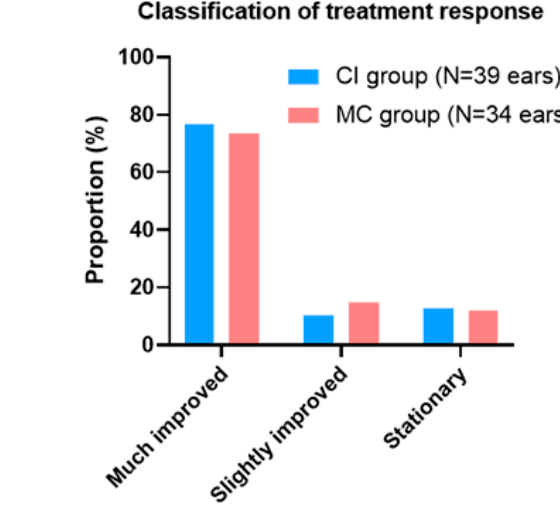
Figure 5. Comparison of erythema score during follow-up periods between the two groups. ( A ) Within CI group. ( B ) Within MC group. (*: statistical significance, ns: no statistifcal significance) 4. Discussion The current study compared the therapeutic efficacy of PEAC treatments between the CI and MC groups. Both groups showed favorable treatment outcomes following ter- mination of the self-application treatment according to the cross-sectional and longitudi- nal analyses. Improvement of the itching sensation was demonstrated subjectively based